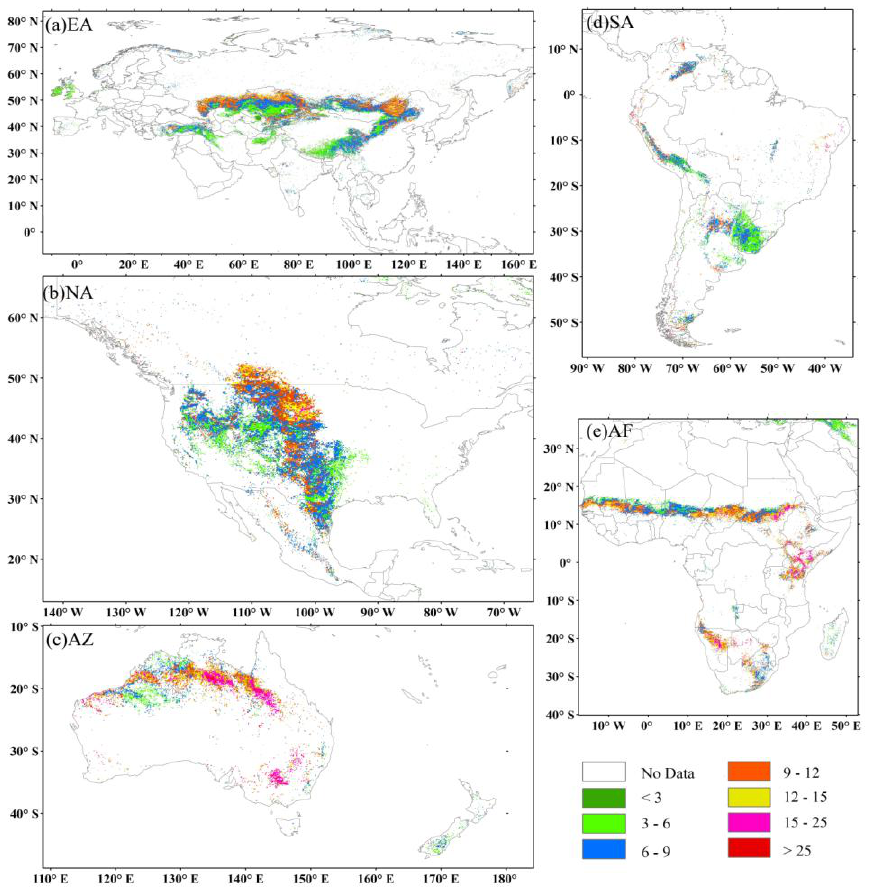
aboveground live biomass carbon density in the five regions ( i.e. , ( a ) Europe and Asia (EA), ( b ) North America (NA), ( c ) Australia and New Zealand (AZ), ( d ) South America (SA), and ( e ) Africa (AF)) from 1982 to